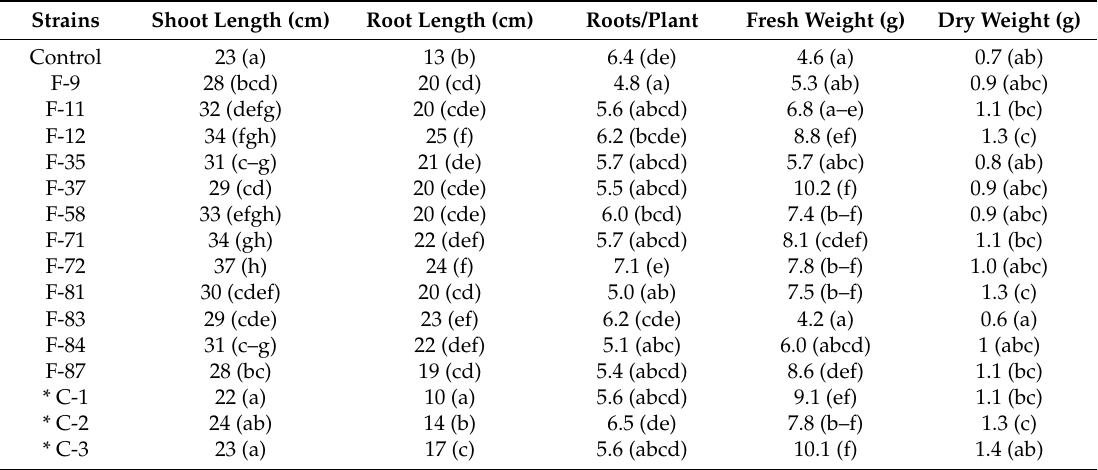
23 (a) Mean of 10 plants. Different letters within same column indicate significant difference between treatments using Duncan’s multiple range rest ( p ≤ 0.05); * Mixed culture combinations: C-1 (F-9, F-11, F-12, F-87), C-2 (F-35,